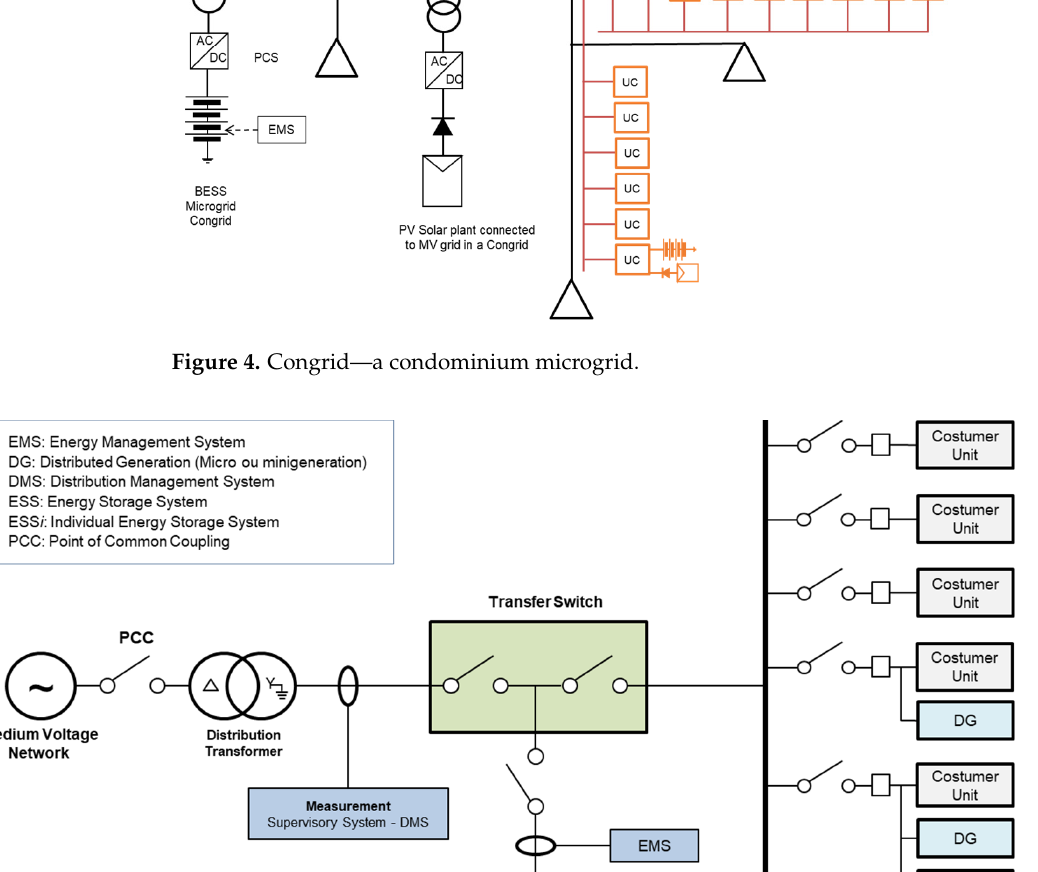
Concrete pole – Low Voltage Grid Figure 6. MERGE congrid—a condominial microgrid. In summary, Table 3 describes the main characteristics and a proposed framework for the classification of nanogrids, congrids and Campusgrids, considering the regulatory struc- ture and the technical limits of voltage and contracted power demand at the point of con- nection, observing and in compliance with REN ANEEL nº 1.000, of 7 December 2021 [46]. Condominium Microgrid - Congrid